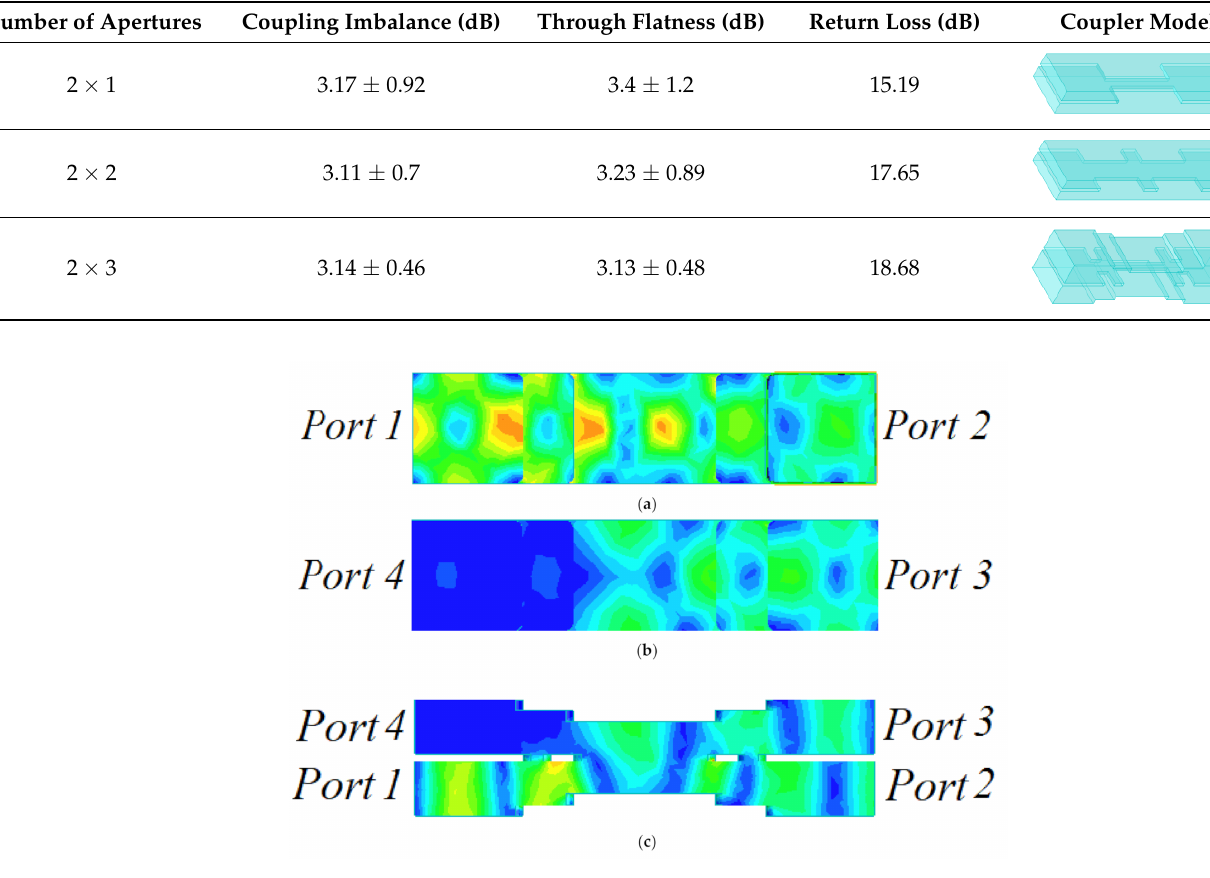
Figure 2. Surface current density at 33 GHz: ( a ) bottom view, ( b ) top view, and ( c ) side